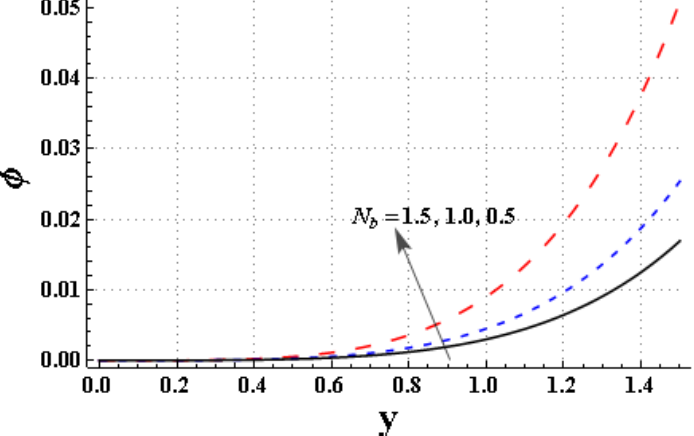
N N N , on the concentration of nanomaterials, , on the concentration of nanomaterials, , on the concentration of nanomaterials,